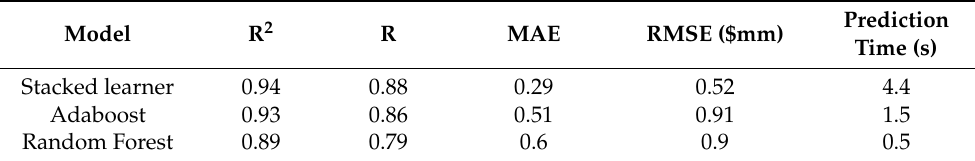
Table 10. Error metrics for proxies with revenue.